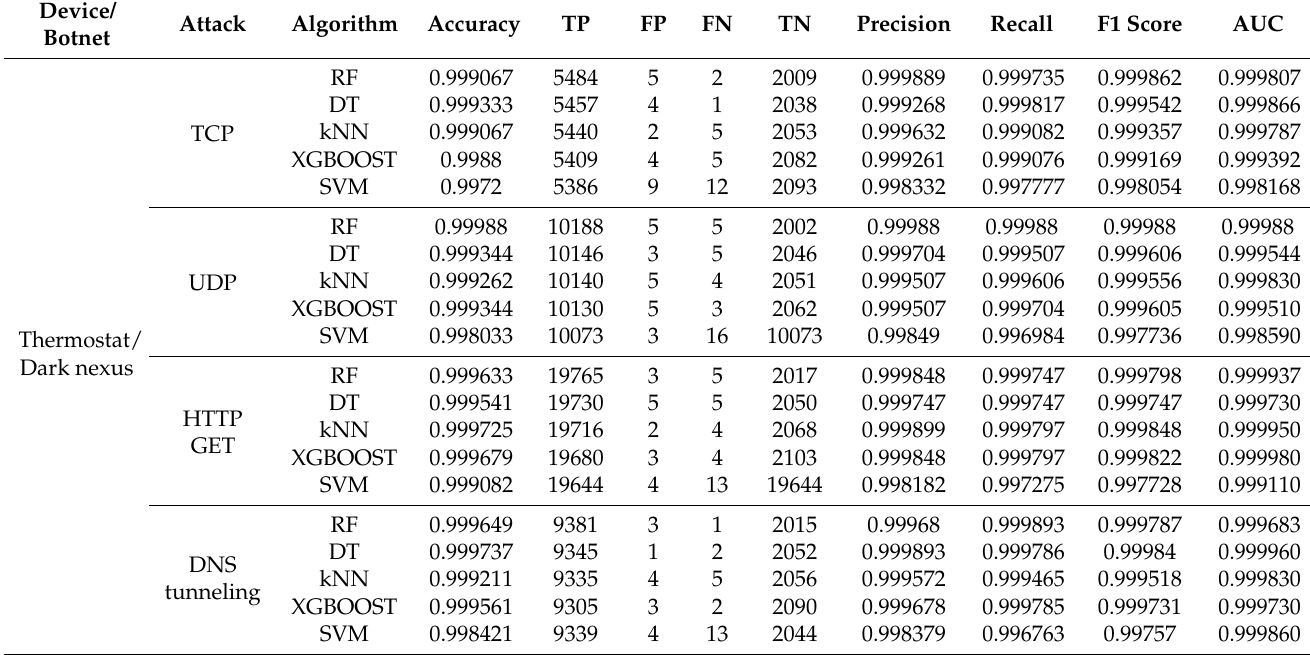
Table 16. Classification results (thermostat—Dark Nexus).